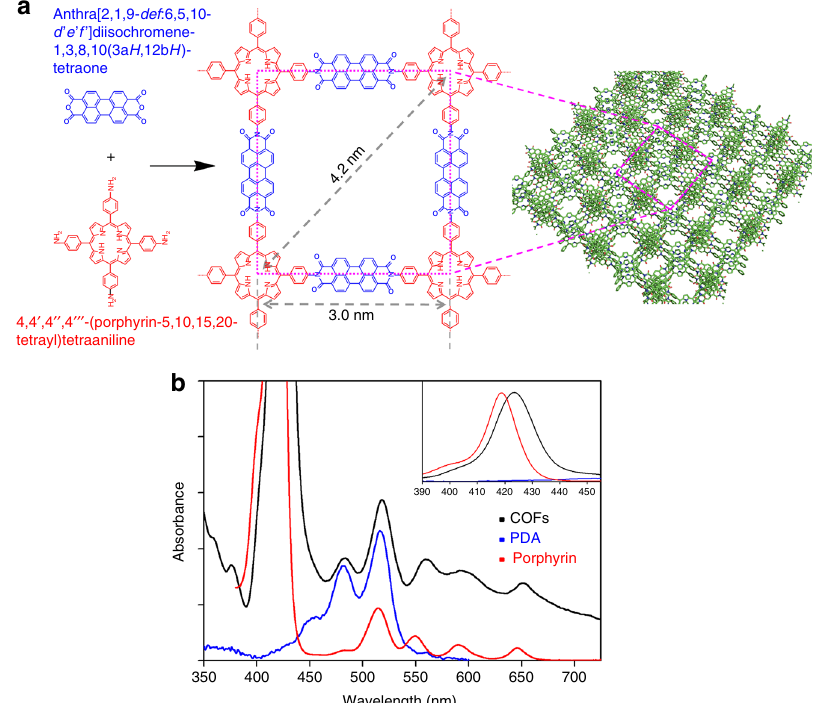
Fig. 1 Molecular structure and steady-state absorption spectra. a Molecular structure of two-dimensional covalent organic frameworks (COFs). For the clear visualization, the repeat units in 2D sheets are truncated from the stacked structure of COFs (green skeleton). The COFs consist of two units, 3,4,9,10-perylenetetracarboxylic acid diimide (PDI) and free-base porphyrin, which are colored in blue and red, respectively. b Electronic absorption spectrum of PDI-porphyrin COFs dispersed in DMF (black), together with the normalized absorption spectra of their precursor molecules, free-base porphyrin (red), and perylene-3,4,9,10-tetracarboxylic dianhydride called as PDA